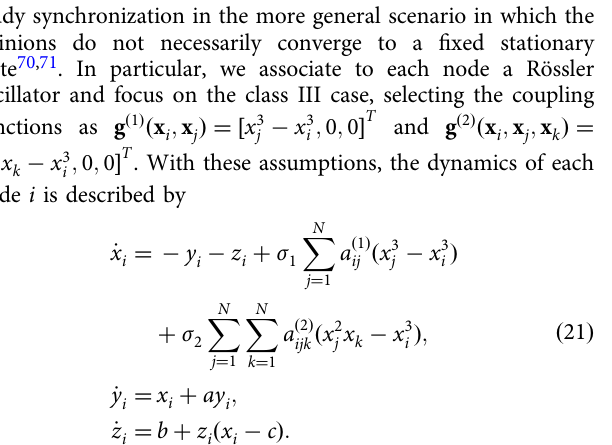
; 0 (cid:3) T and h ð 2 Þ ð x j (cid:3) T and h ð 2 Þ ð x j